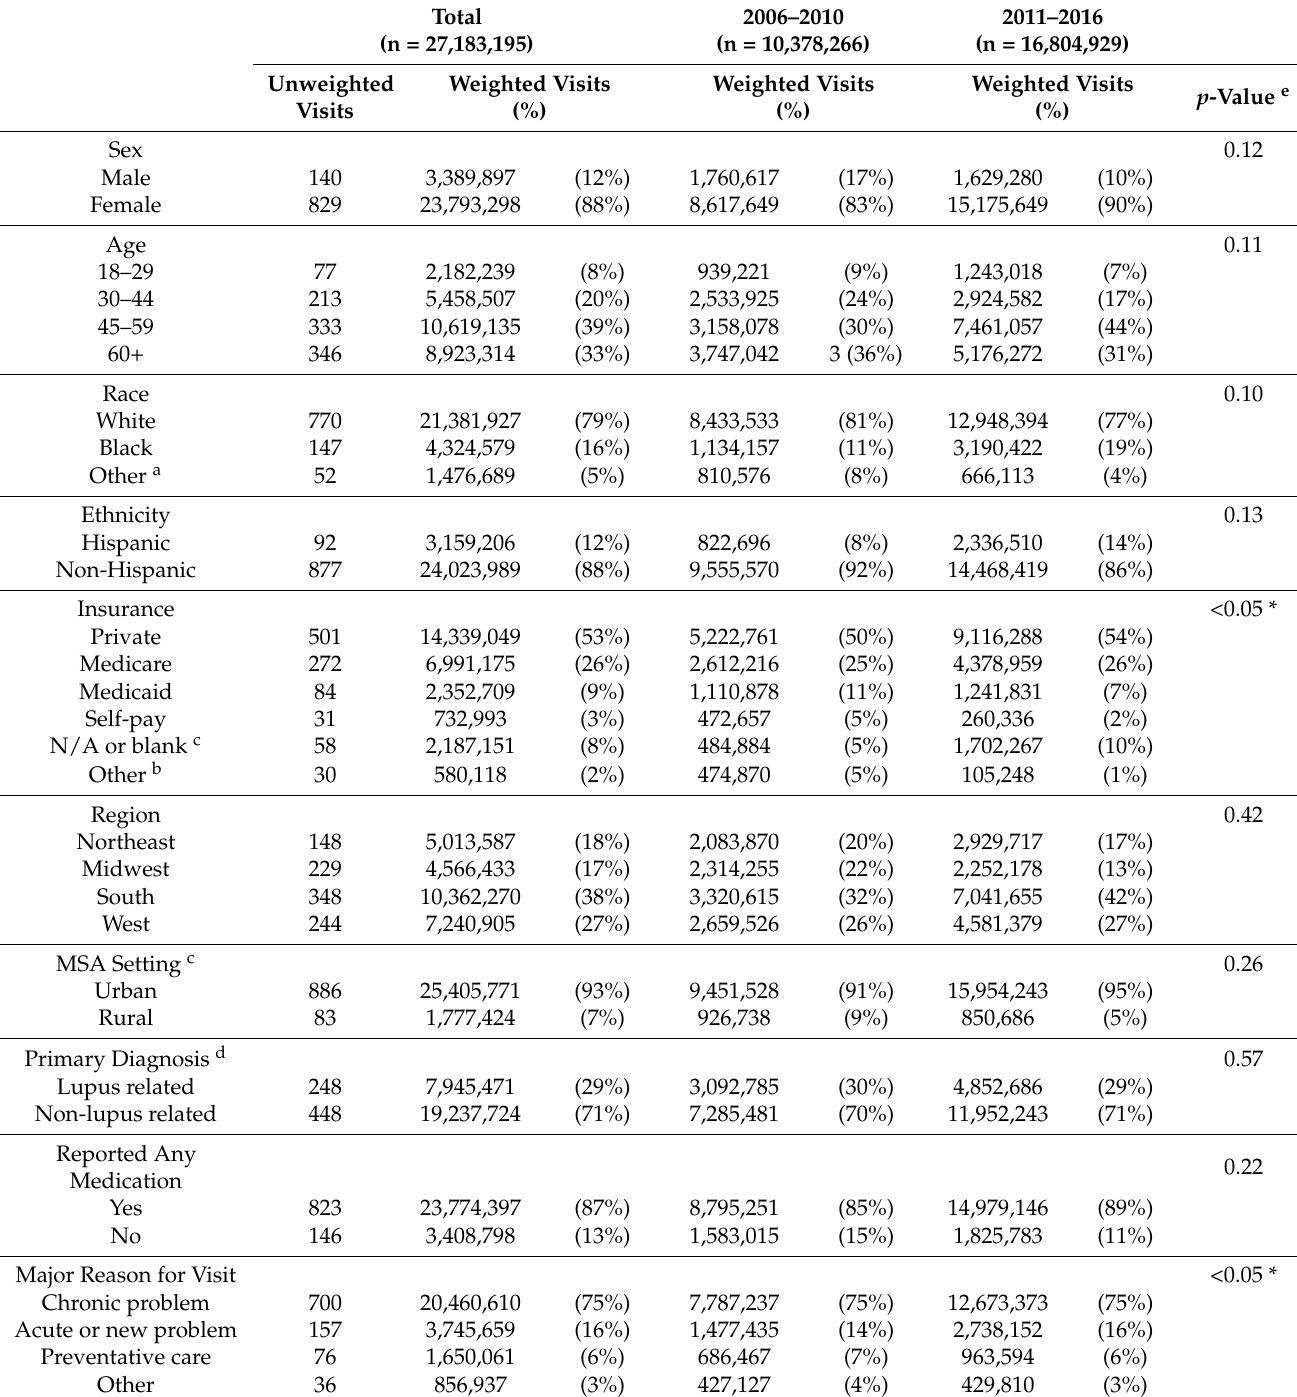
Table 1. Patient and visit characteristics of all patients diagnosed with lupus